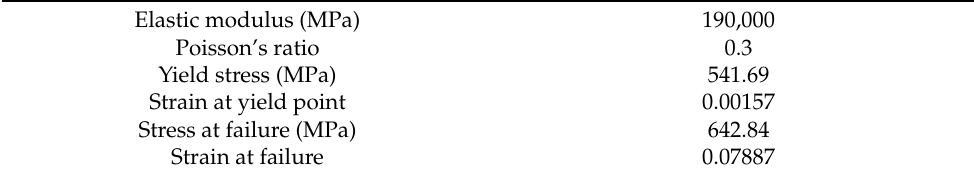
Table 2. Mechanical properties for steel reinforcement bars.